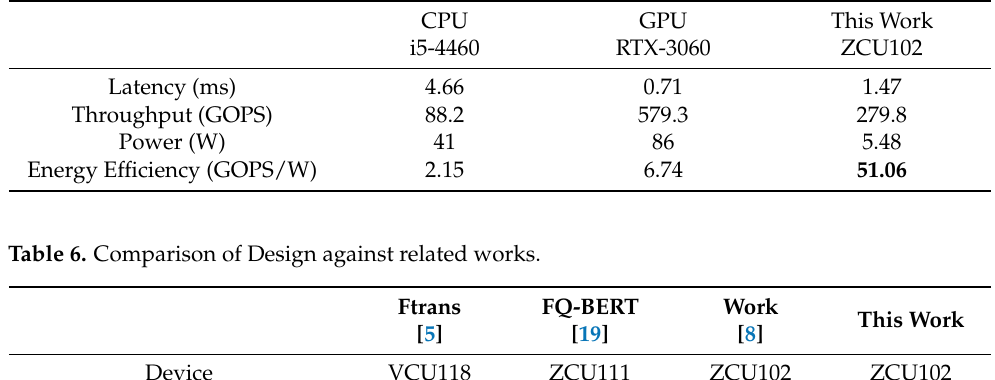
Table 5. Comparison of Design against CPU and GPU.